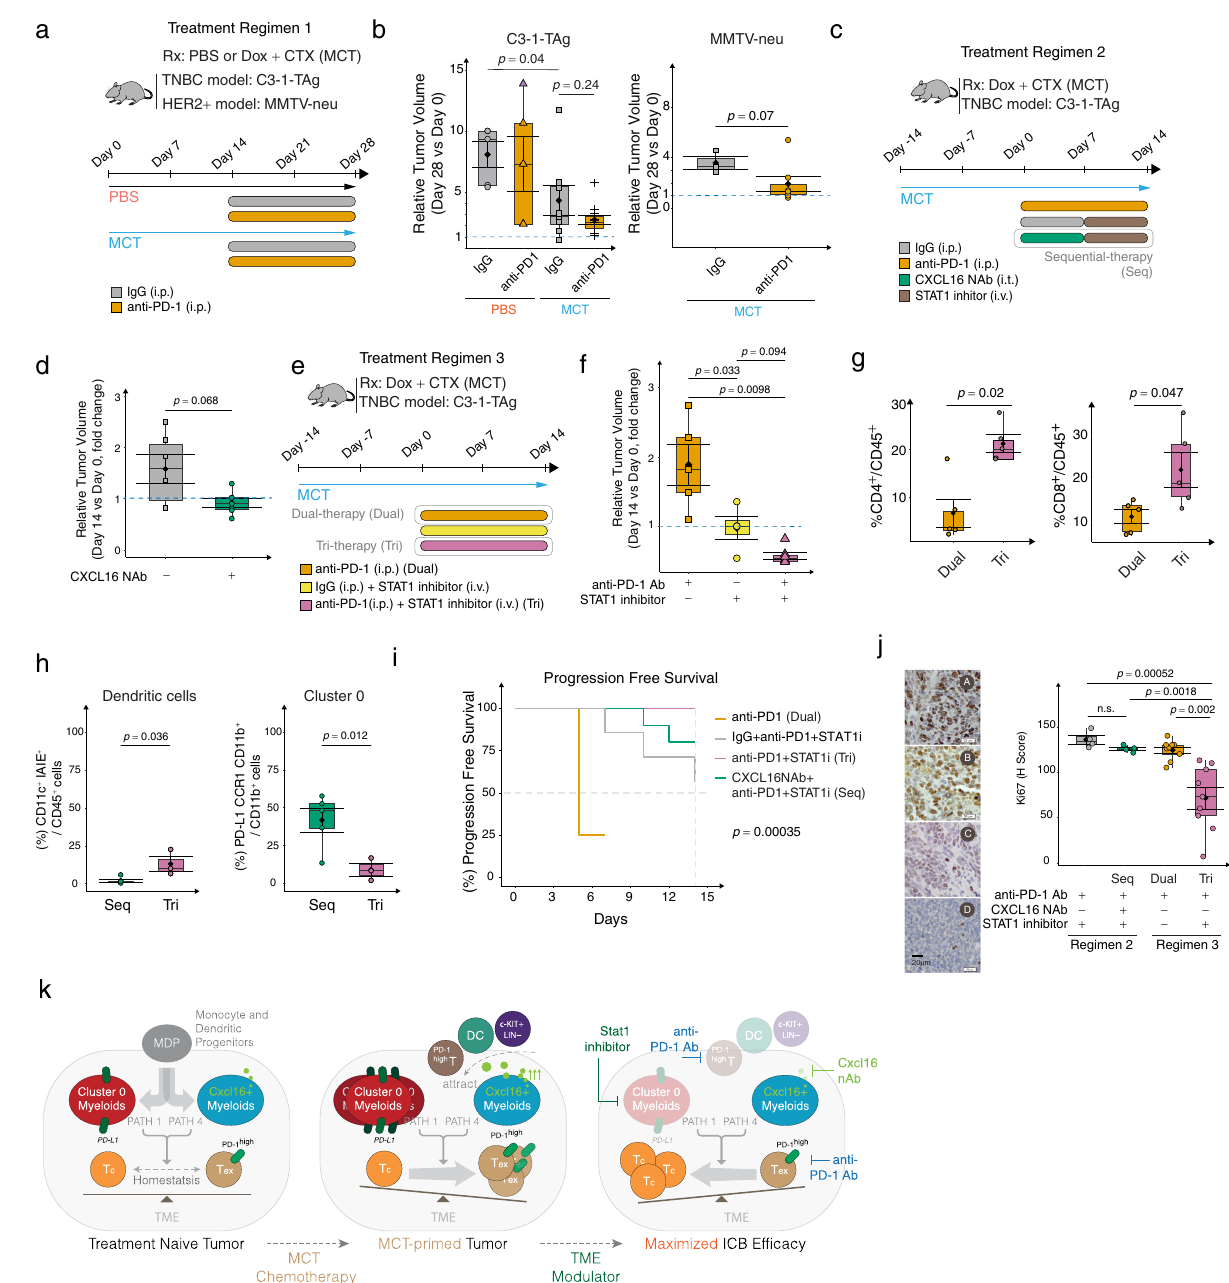
Fig. 6 | Modulating STAT1 signaling enhances anti-PD-1 antibody mediated anti-tumor responses. a Treatment scheme for synergizing anti-PD-1 with MCT (Regimen 1). b Box plots show tumor volumes on Day 28 of treatment (Regimen 1) relativetoDay0inC3-1-TAg(left)andMMTV-neu(right)mice. n =3 – 5micepooled over three cohorts. c Treatment scheme for synergizing CXCL16 NAb with STAT1i response in MCT and anti-PD-1 treated mice (Regimen 2). d Box plots show tumor volumes on Day 14 of treatment (Regimen 2) relative to Day 0 in C3-1-TAg mice. n =3 – 5micepooledoverthreecohorts. e TreatmentschemeforsynergizingSTAT1i and anti-PD-1 antibody response (Regimen 3). f Box plots show tumor volumes on Day 14 of treatment (Regimen 3) relative to Day 0 in C3-1-TAg mice. n =3 – 5 mice pooled overthree cohorts.Boxplotsquantify fl owcytometryidenti fi ed g Tcellsin DualandTri-therapyand h dendriticcellsandCluster0cellsinSeq-therapyandTri-